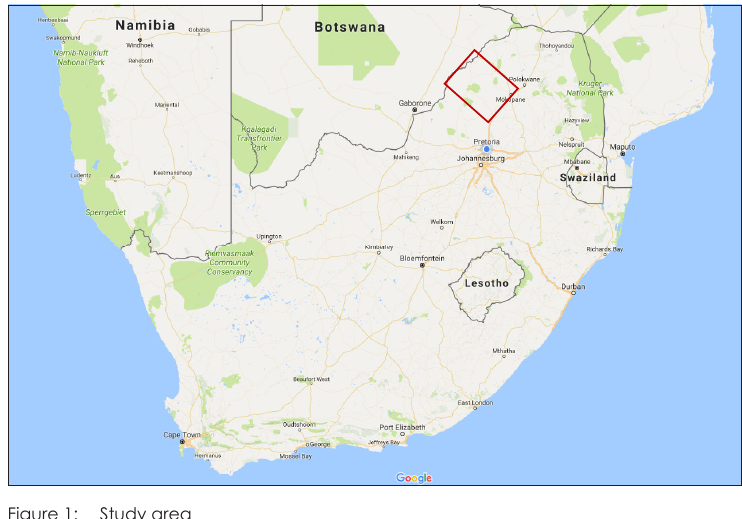
Figure 1: Study area Source: Google